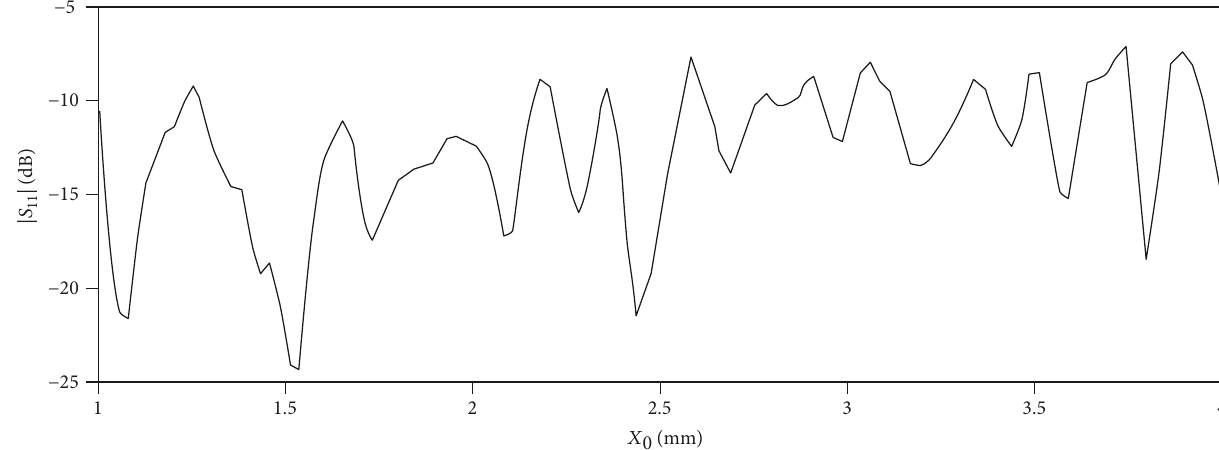
, for the Koch fractal antenna of level k = 2 0